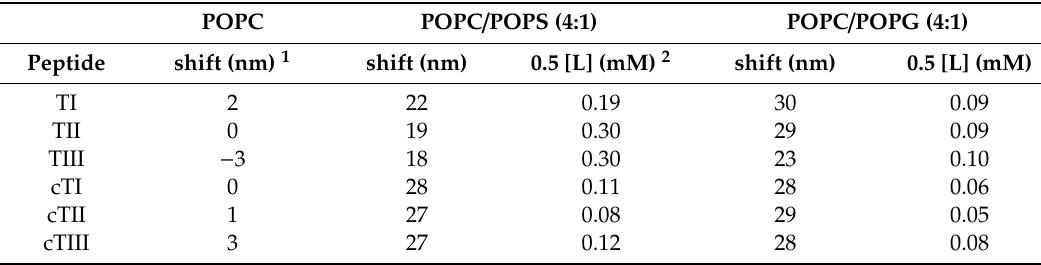
Table 7. Shift in the fluorescence emission maximum wavelength of tachyplesin I–III (TI-TIII) and cyclic analogues (cTI-cTIII) in bu ff er and in the presence of model